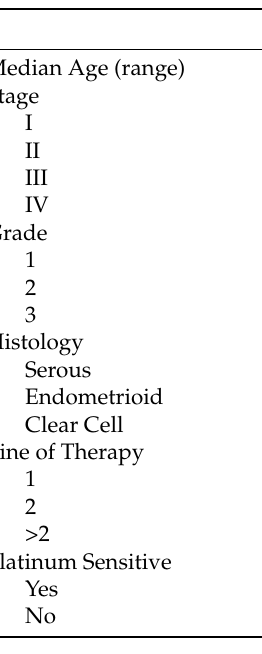
Table 1. Patient demographics of main patient